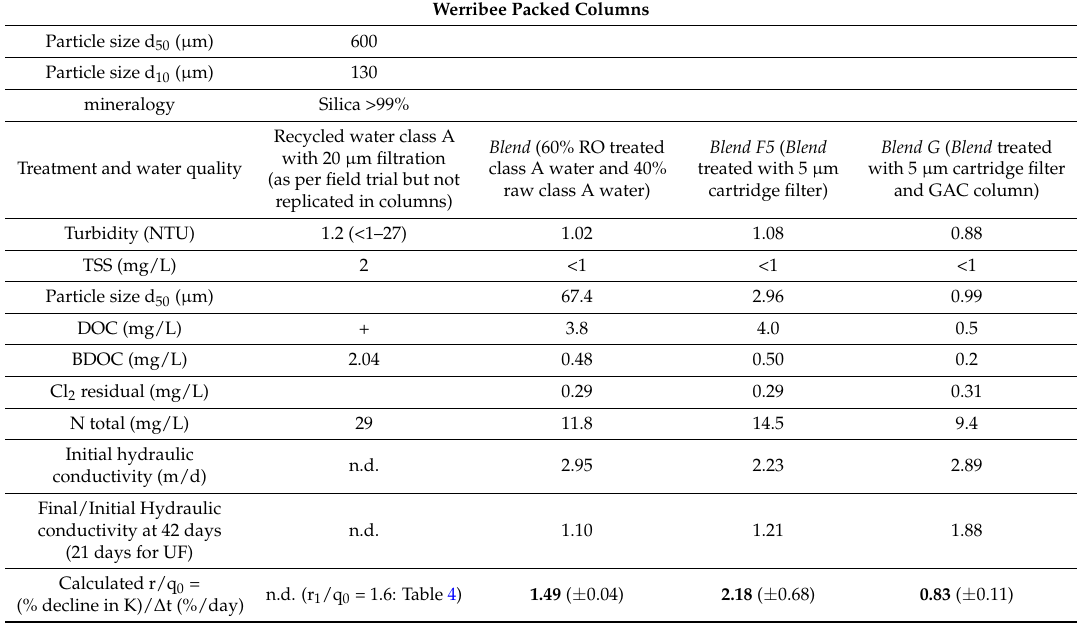
Table 7. Summary of column study tests of clogging with Werribee sand and recycled water with different treatments (from Barry et al.